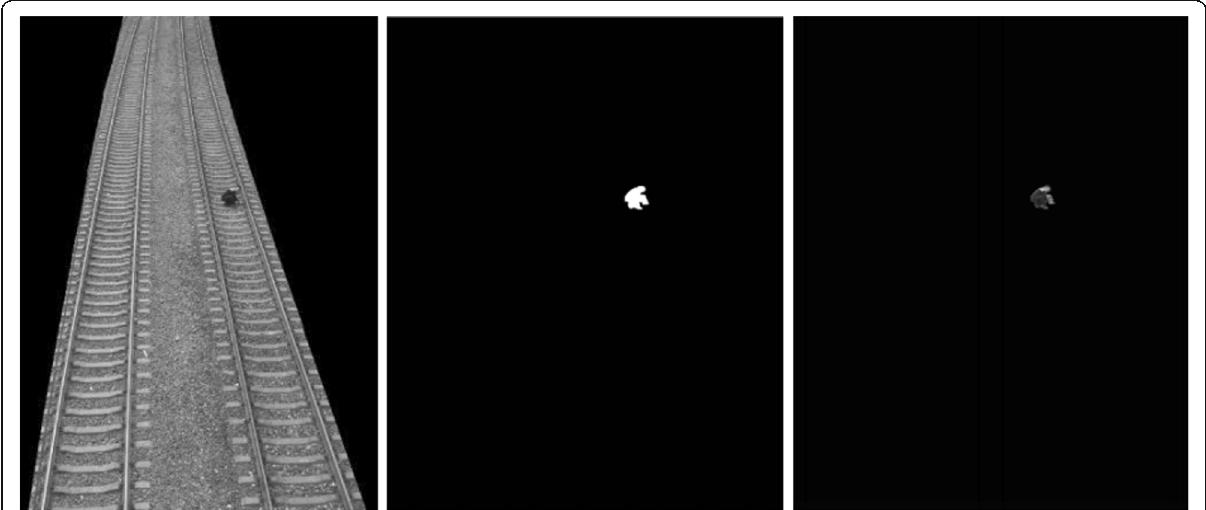
Fig. 7 Foreign matter extraction. a Screenshot of foreign object invasion. b Extracted foreign matter area. c Extracted foreign